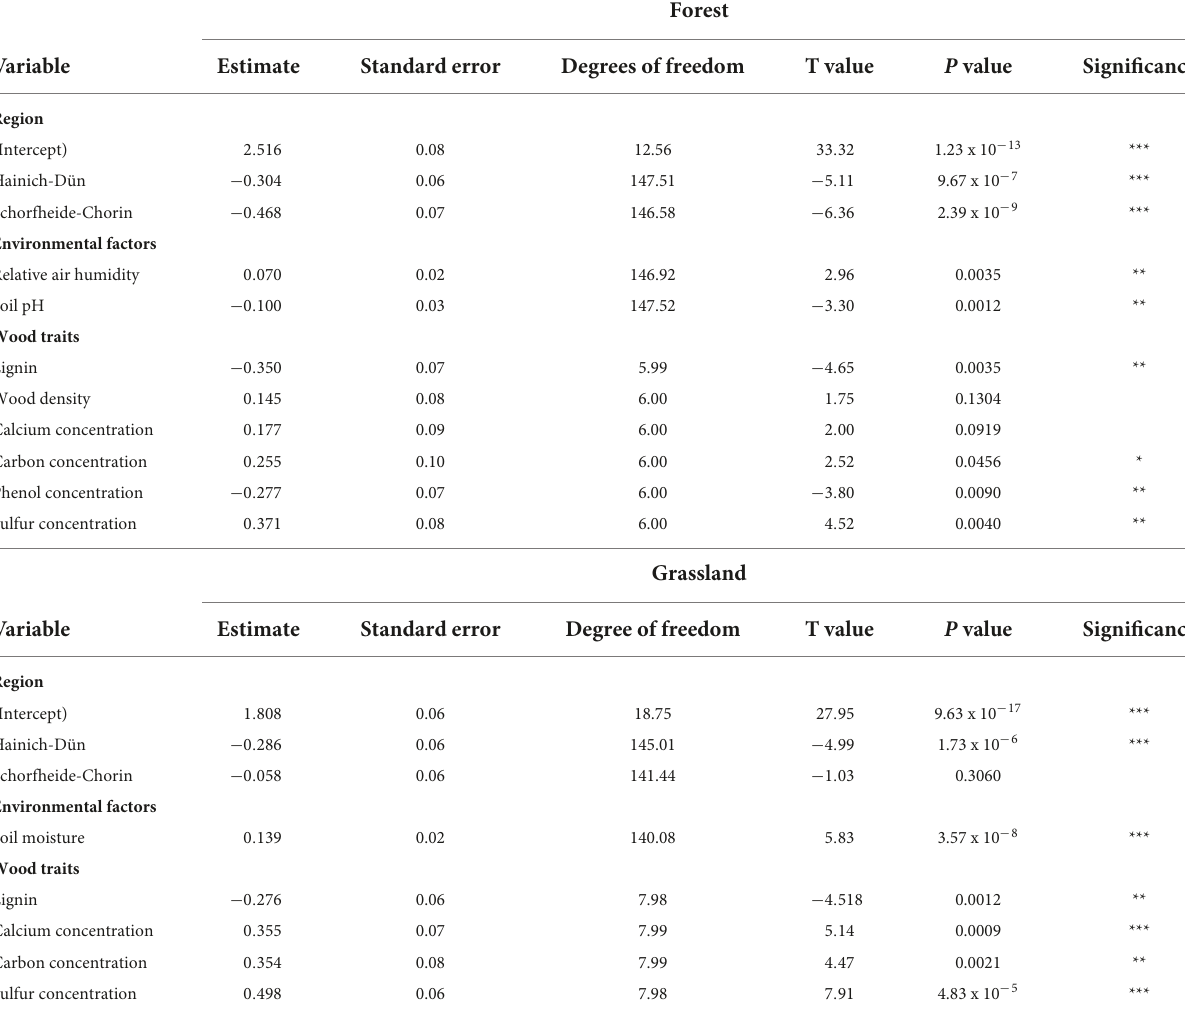
TABLE 3 Results of final models for importance variables of tree species traits, environmental factors and land-use intensity on mass loss (Model